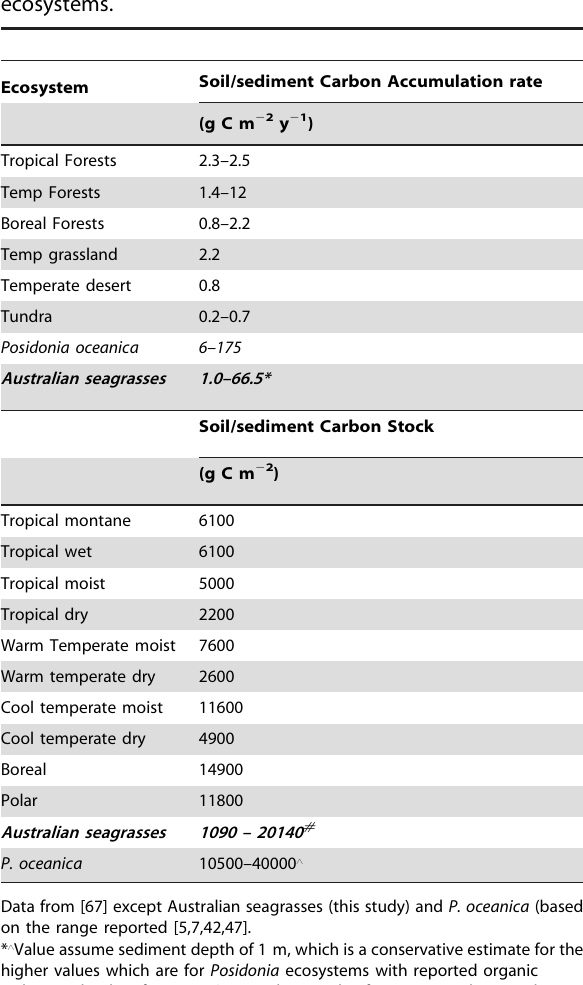
Table 8. Estimated annual C org stocks in soils of different